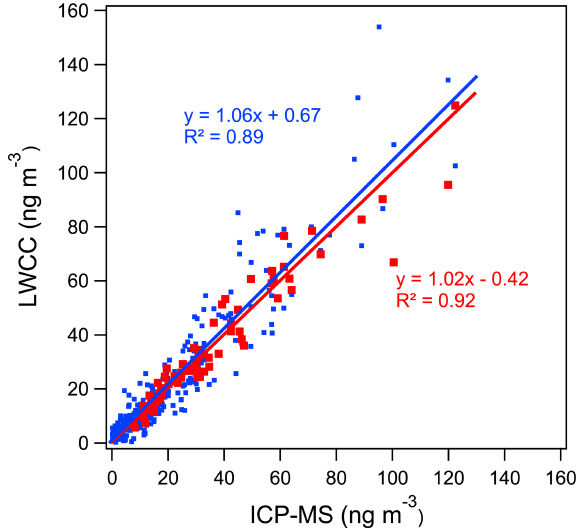
Figure 4. Comparison between LWCC method and ICP-MS method for WS Fe with pH adjustment of the light-absorbing sam- ple. The blue points and line represent the original method without ammonium acetate and with pH of ∼ 1. The red points and line re- fer to the improved method with ammonium acetate and with pH of 4 to 5 (results of York regression are